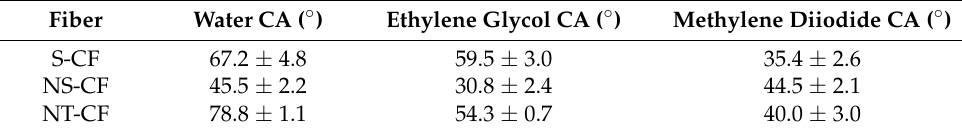
Table 6. Dynamic contact angles (CA) from tensiometer measurements.